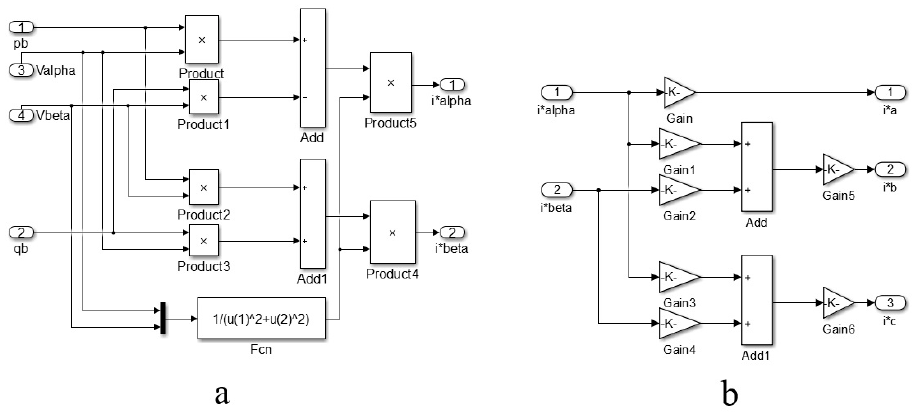
Figure 16. After compensation current ( a ) source; ( b ) load.